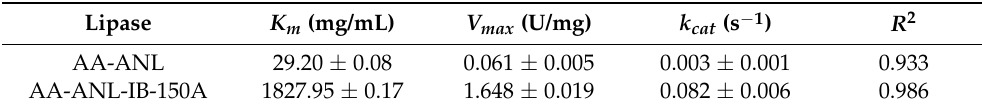
Table 9. Kinetic parameters of immobilized AA-ANL compared with lipase in free form. Data are presented as a means ± standard deviations of three analyses ( n =